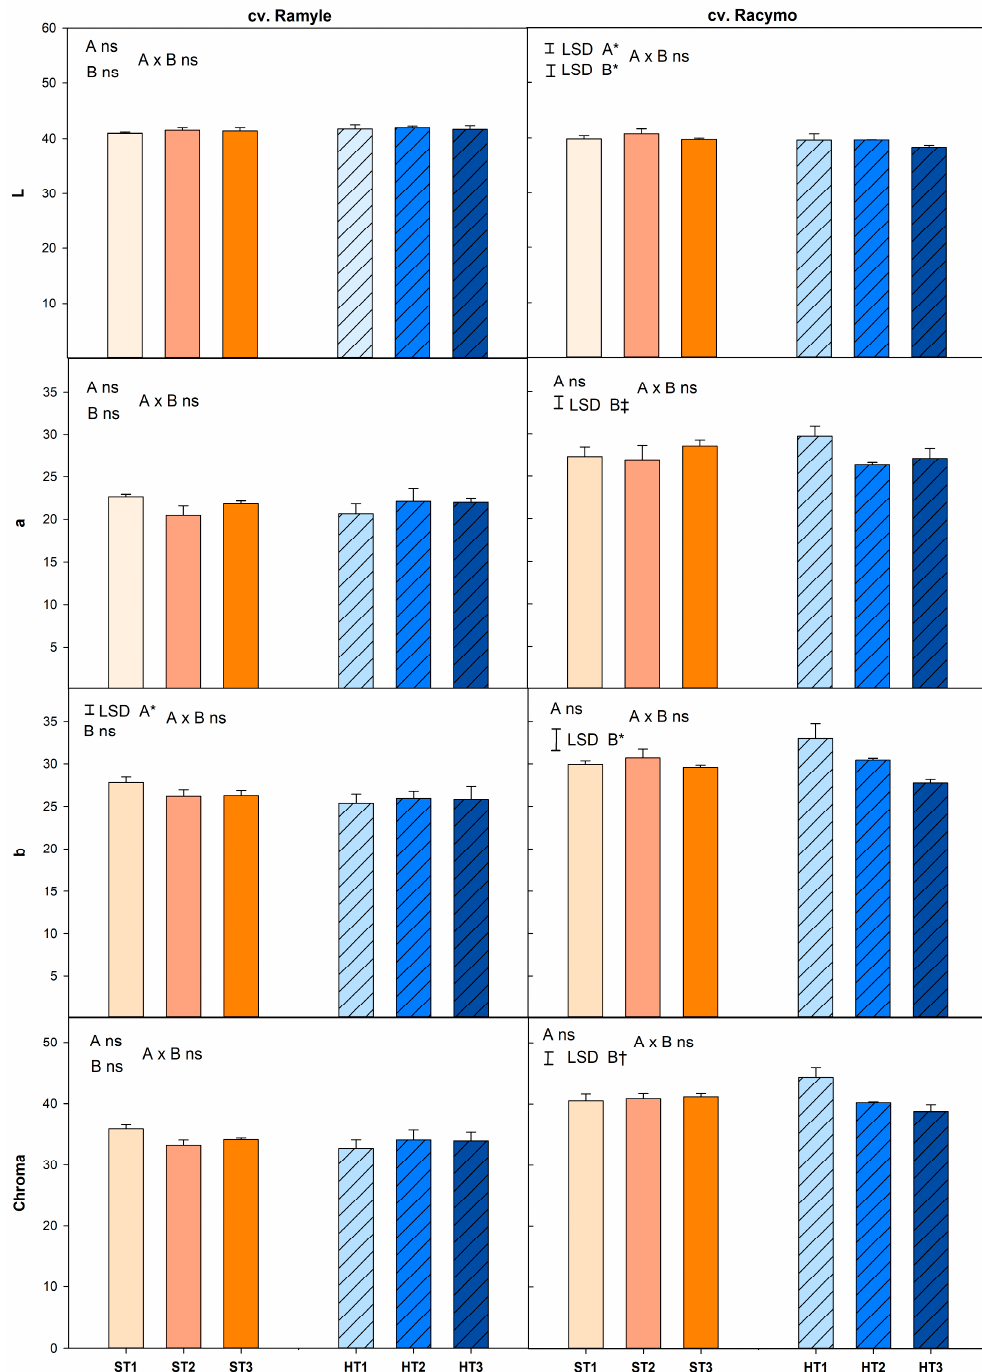
Figure 4. Color (L, a, b and Chroma) of two tomatoes (cvs. Ramyle and cv. Racymo) under different irrigation treatments (T1: desalinated seawater with low electrical conductivity (EC); T2: well/desalinated water, intermediate EC; and T3: well water with high EC) and cultivation systems (traditional soil system, S; hydroponic, H) ( n = 3 ± SD). The uppercase letters A and B denote cultivation system and irrigation treatment, respectively. ns, *, † , and ‡ significance for p ≤ not significant, 0.05, 0.01, and 0.001, respectively.